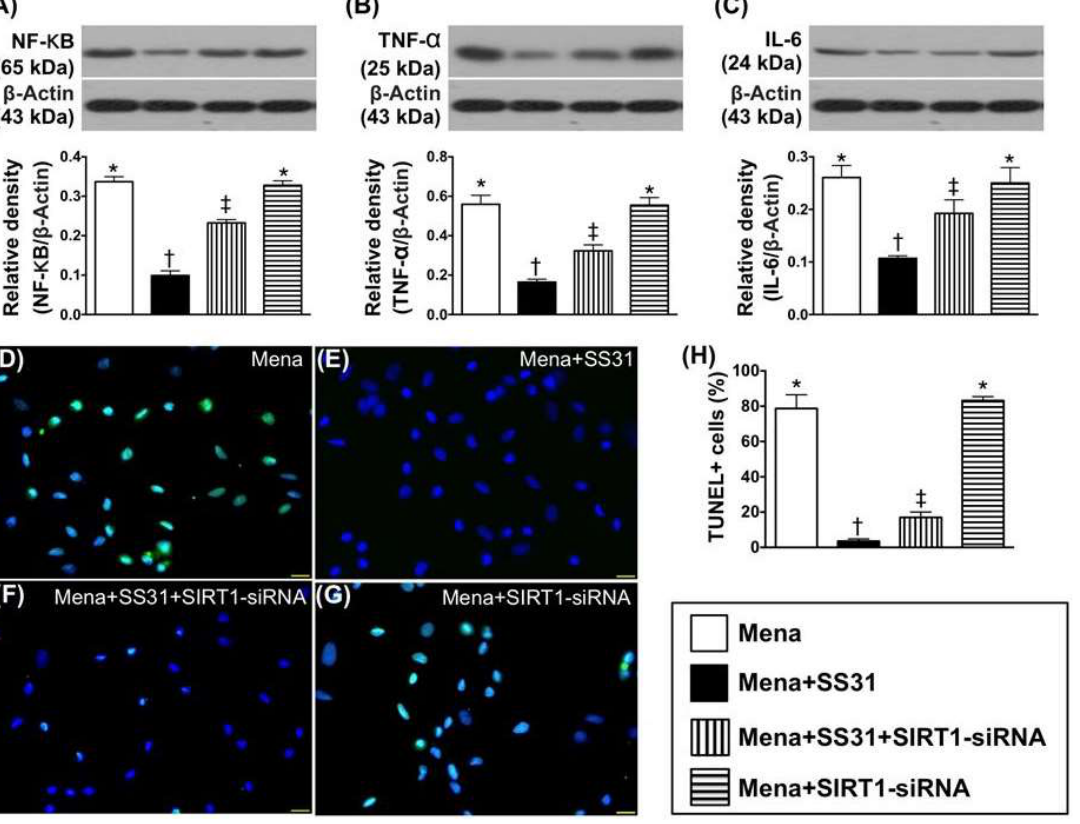
Figure 4. SIRT1 suppression inhibits SS31-mediated cyto-protective effect. ( A ) Protein expression of nuclear factor (NF)- κ B, * vs. other groups with different symbols (†, ‡), p < 0.0001. ( B ) Protein expression of tumor necrosis factor (TNF)- α * vs. other groups with different symbols (†, ‡), p < 0.0001. ( C ) Protein expression of interleukin (IL)-6 * vs. other groups with different symbols (†, ‡), p < 0.0001. ( D – G ) Illustrating the immunofluorescent microscopic finding (400 × ) of TUNEL assay for identification of apoptotic nuclei (green color) in H9C2 cells (green color). ( H ) Analytical result of the number of apoptotic nuclei * vs. other groups with different symbols (†, ‡), p < 0.0001. All statistical analyses were performed by one-way ANOVA, which was followed by a Bonferroni multiple comparison post hoc test ( n = 6 for each group). Symbols (*, †, ‡) indicate significance at the 0.05 level. Mena = menadione.